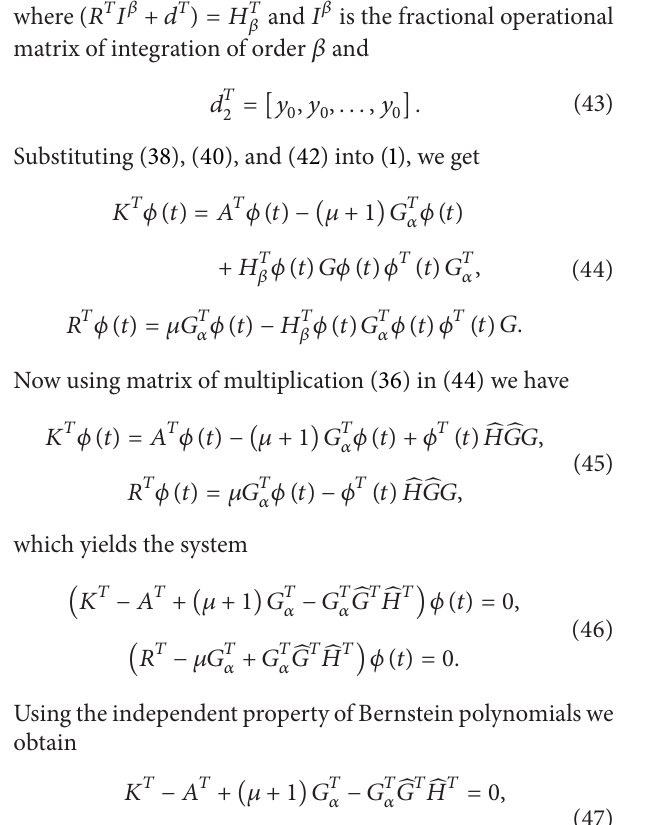
Similarly, we approximate 𝑦(𝑡) from (1) by Bernstein polyno- mials